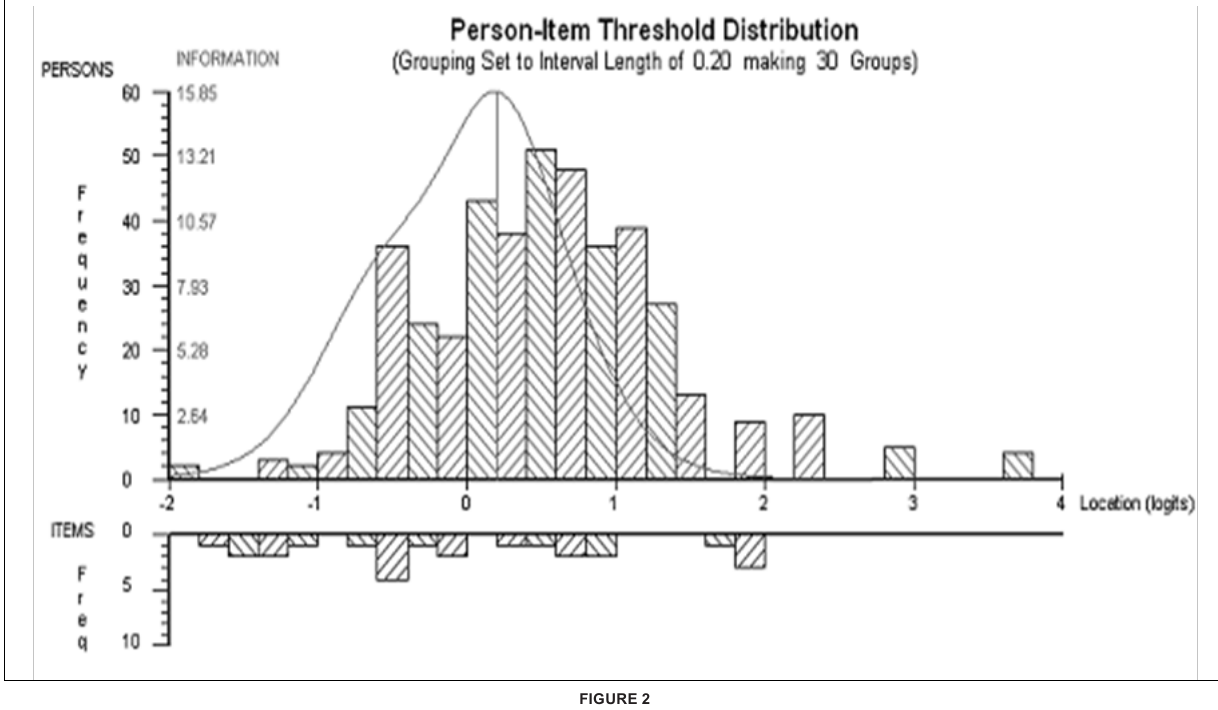
FIGURE 2 Person-item threshold distribution and information function for the Values Driven Scale